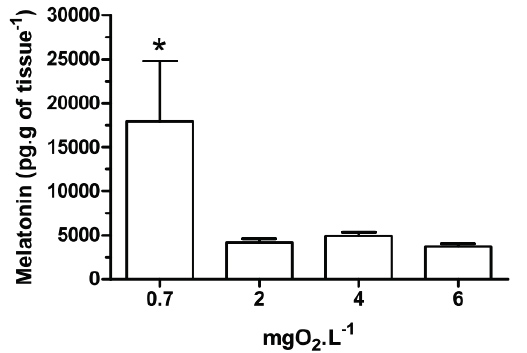
Figure 1. Melatonin content in the eyestalks of the crab Neohelice granulata in vitro . The eyestalks were incubated for 45 min at 0.7, 2, 4 or 6 mgO 2 ·L − 1 . Each point represents the mean ± standard error (SE) ( n = 5). * represents a significant difference ( p < 0.05) from the other